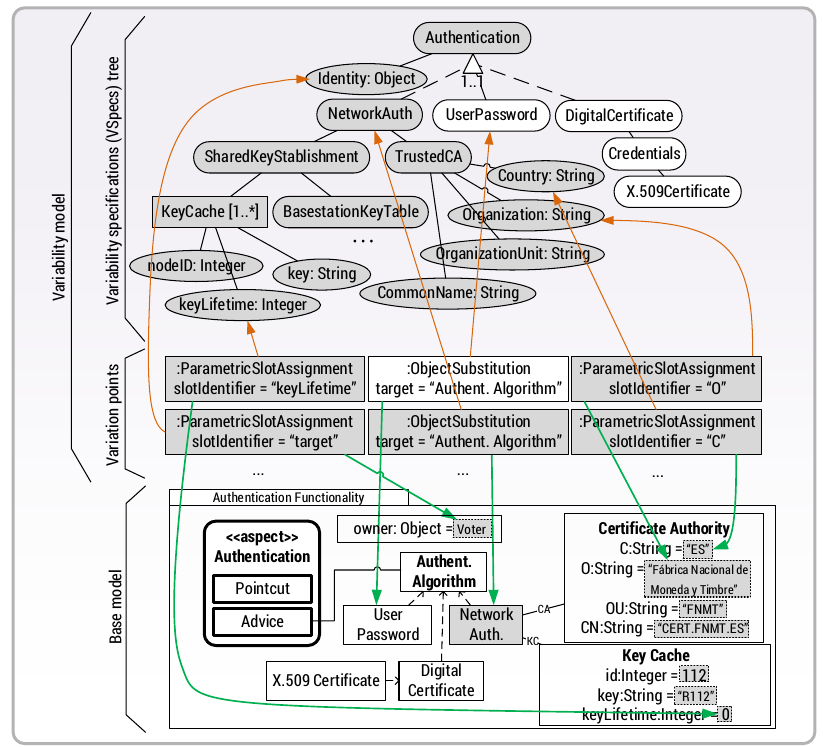
Figure 7. Resolution model of the authentication